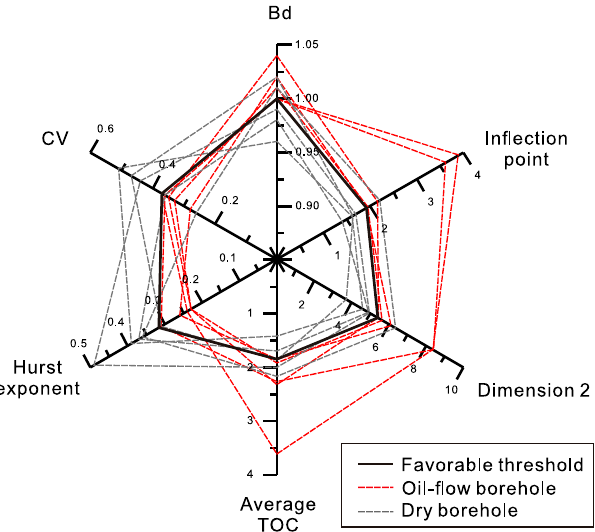
Figure 8. Radar plot of conventional parameter average TOC and fractal parameters of boreholes. TOC: total organic carbon. CV: coefficients of variance. Bd: box dimensions.